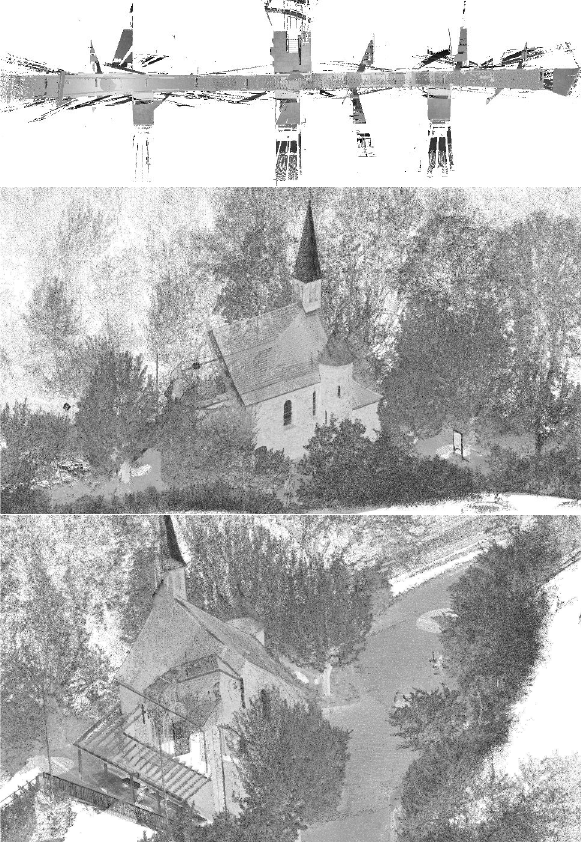
Figure 5. Ground truth data acquired with a Riegl VZ-400 terrestrial laser scanner. Top view from ”The Hallway” and two perspectives from ”The Chapel”. The Grey values represent the reflectance of the